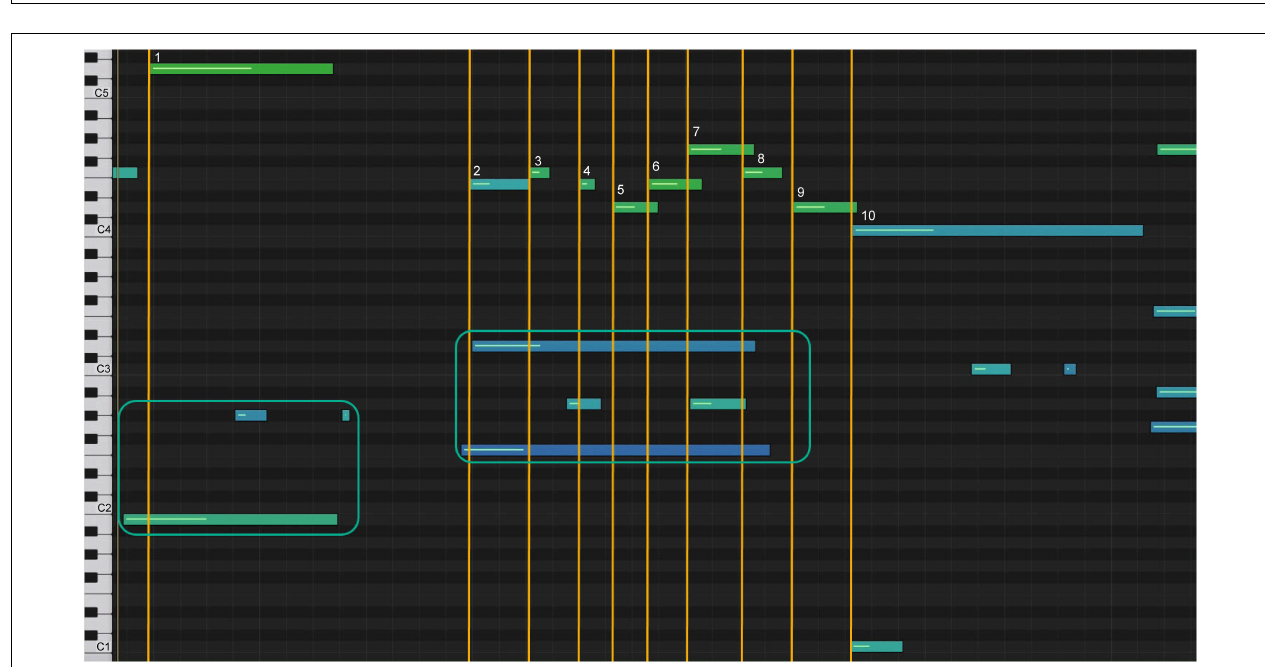
FIGURE 11 | Sonification graph of student’s highpoint before